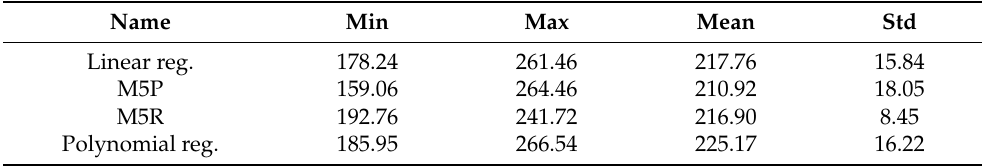
Table 4. Performance statistics after the ROPE process. Minimum (min), maximum (max), mean and the standard deviation (std) are shown in